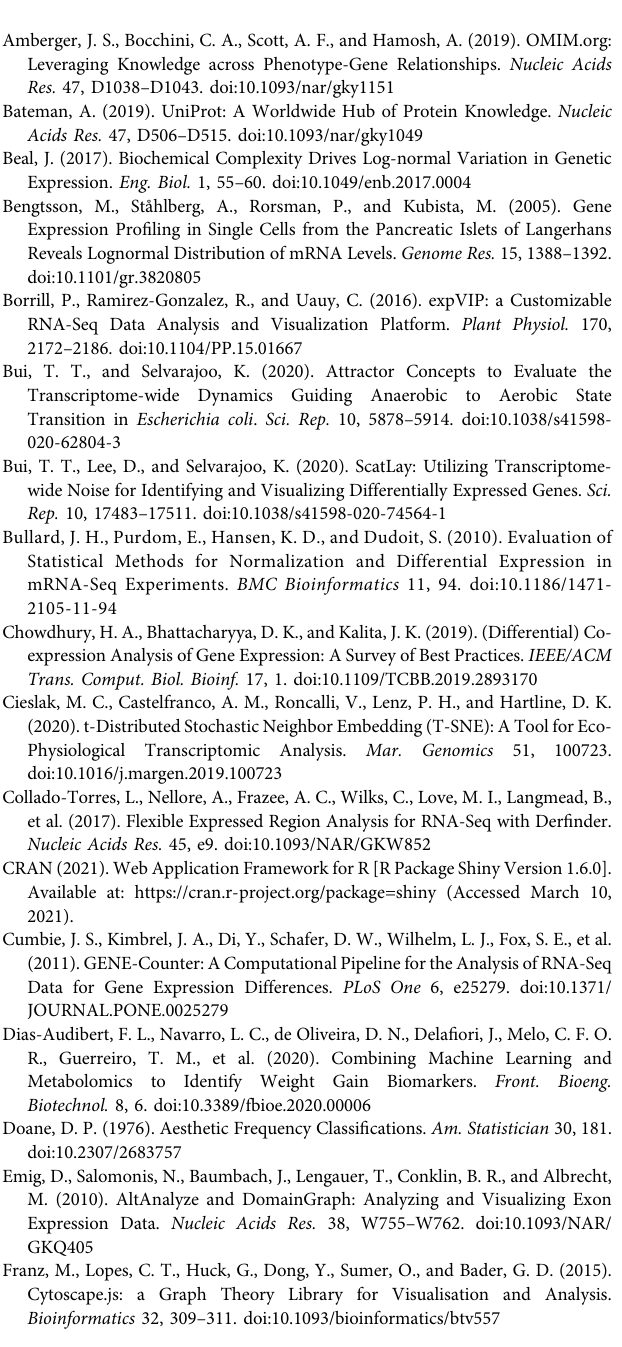
Supplementary Figure S1 | Demonstration of GeneCloudOmics transcriptomic analysis features on (A – E) : bulk-RNASeq human T regulatory cell differentiation data, and (C) : single-cellRNASeq mouse distallungepitheliumdata: (A) : Between-replicate and between-condition transcriptome wide variation visualized by scatter plot. (B, C) : t-SNE(right)visualizeallsampledatapointsin2dimensionsfor (B) :bulk-cellRNA-Seq human T cell data, and (C) : single-cell RNASeq distal lung epithelium data. (D, E) : Estimated dispersion (D) and resulting volcano plot (E) from DESeq2 differential expression analysis with p-value threshold at 0.05 and expression fold threshold at 2.